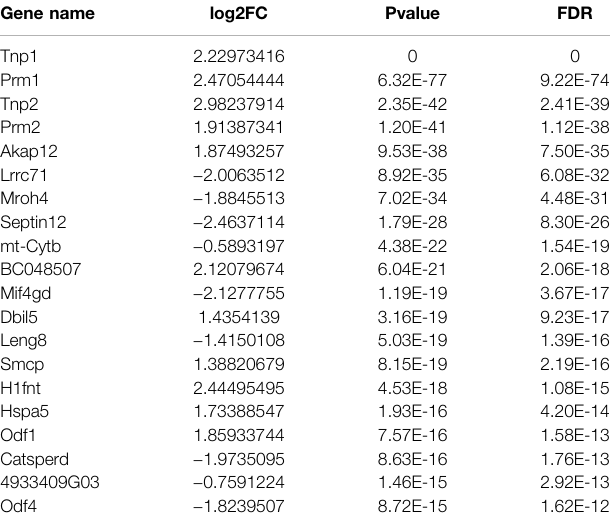
TABLE 2 | The top 20 differential protein-coding genes in Alkbh5 -KO RO and WT RO. Gene